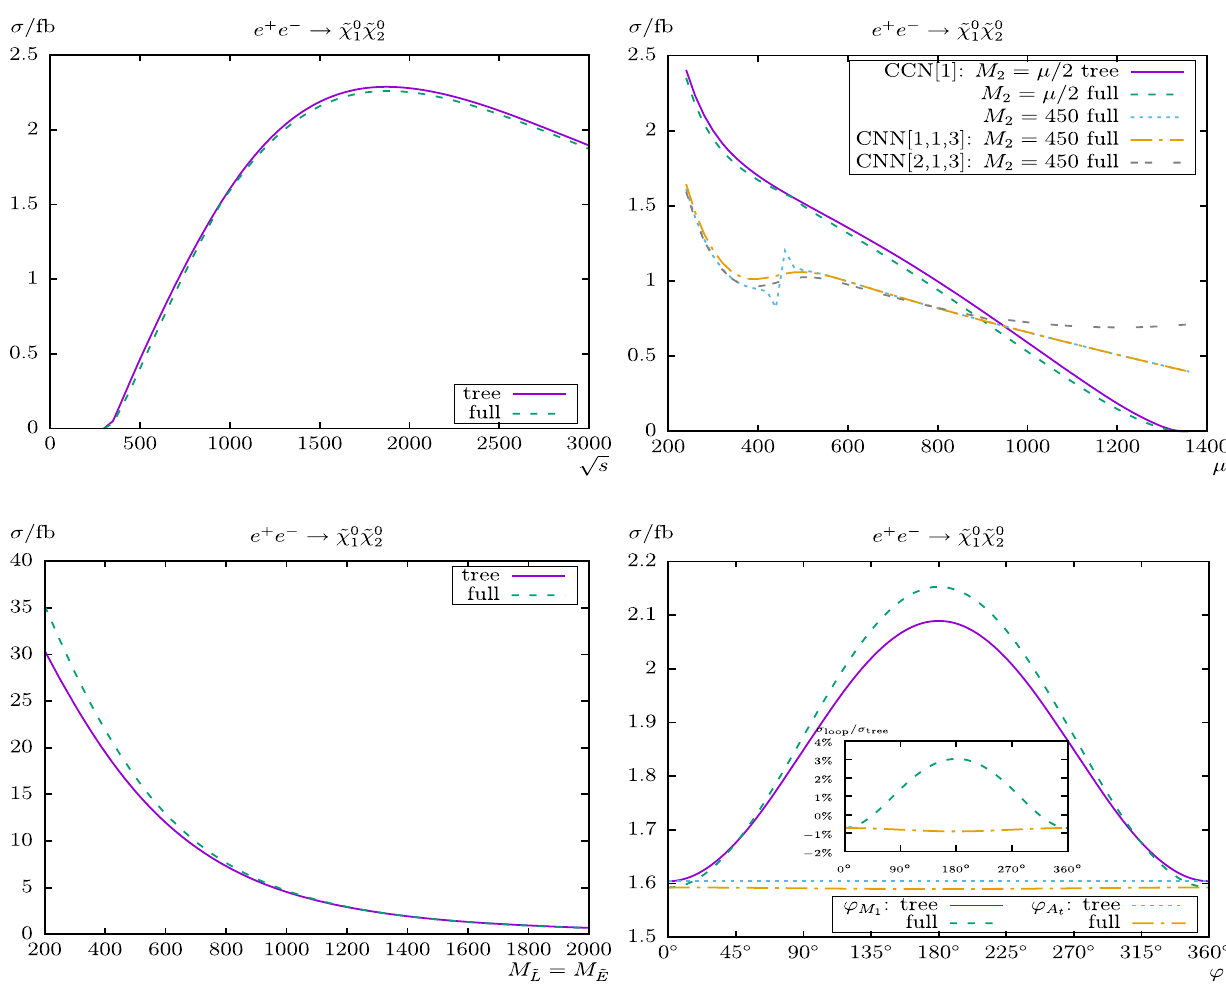
˜ χ 0 ) . Tree-level and full one-loop corrected cross sections are shown with parameters chosen according to S ; see Table 2. 1 2